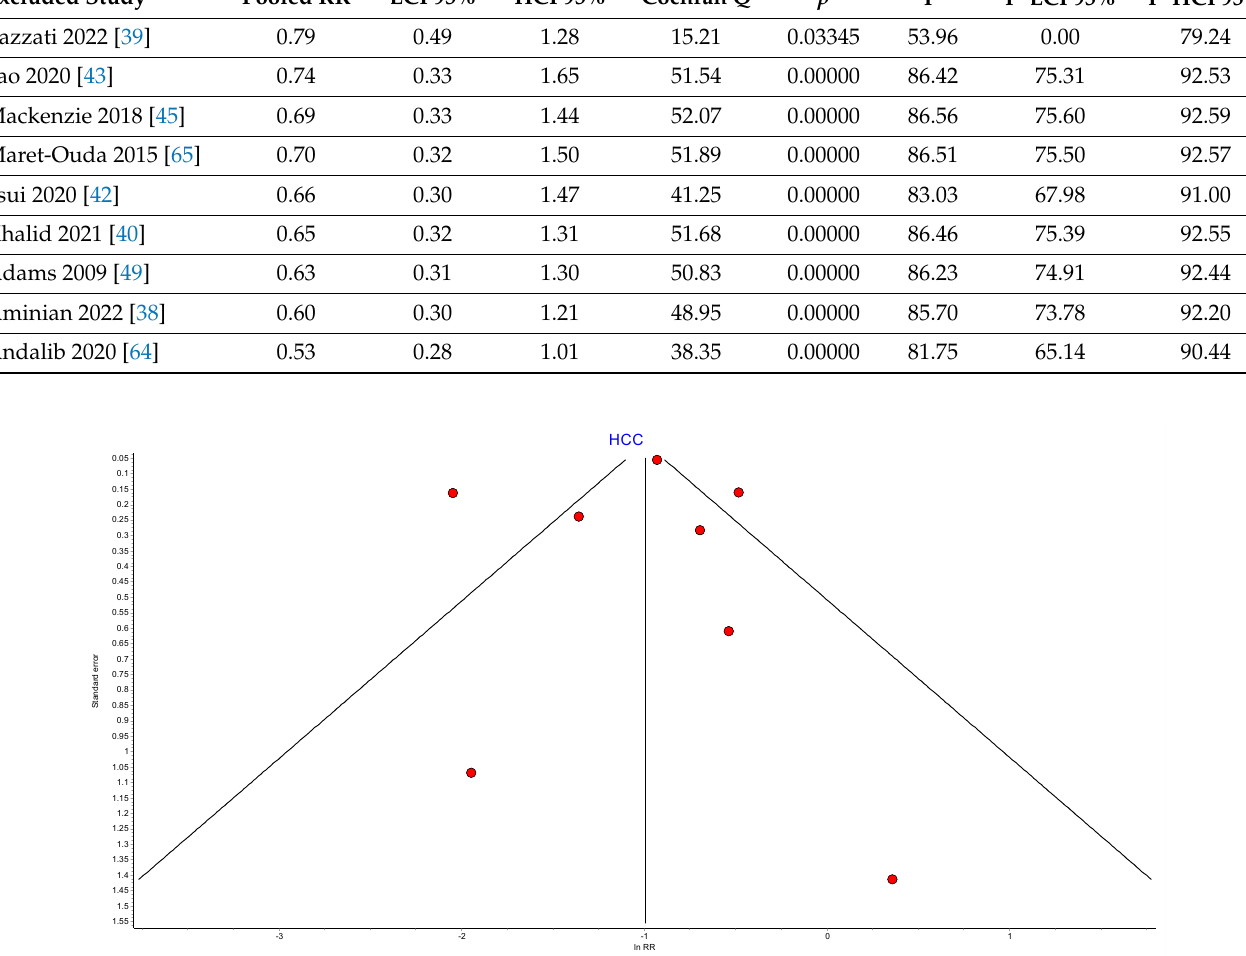
Figure A13. HCC RE model funnel plot. Table A13. HCC random e ff ects model sensitivity analysis.